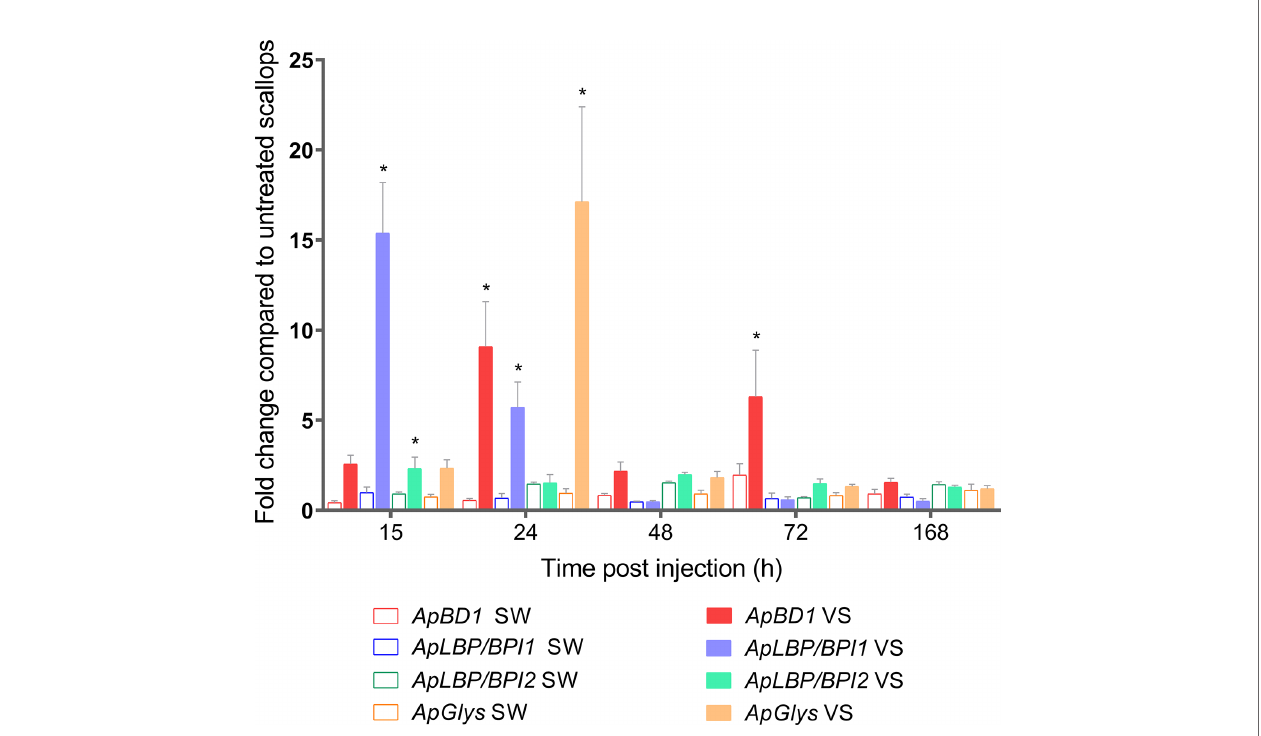
FIGURE 3 | Transcript expression of ApBD1, ApLBP/BPI1, ApLBP/BPI2 , and ApGlys in scallop hemocytes during immune response. Bar graphs indicate the relative expression of antimicrobial effectors genes in Vibrio -injected scallops (VS) and seawater-injected scallops (SW) after 12, 24, 48, 72, and 168 h. SW-injected scallops were considered as injury control condition. Relative expression was calculated using non-stimulated scallops as control group, where gene expression values were considered 1. Graphed data are represented as the mean ± ES (n = 7). Asterisks indicate signi fi cant differences compared to SW-injected scallops (* P <